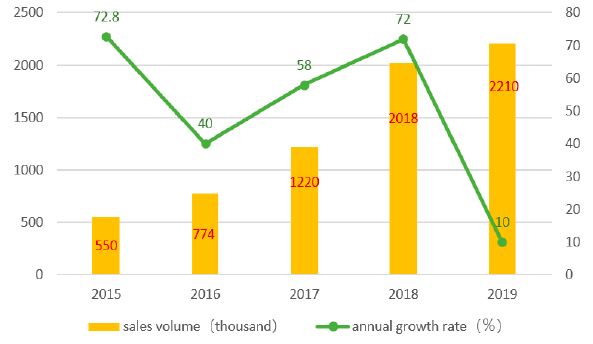
Figure 1. Global electric vehicle (EV) sales, 2015–2019.